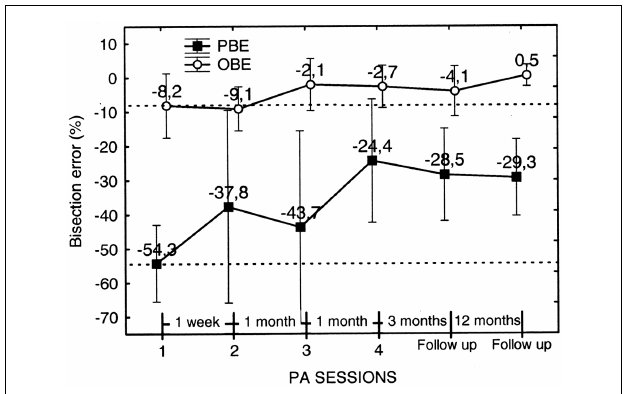
FIGURE 12 | Graphic representation of the effect on the walking bisection error of individual PA sessions (1–4) and of the duration of the effect (follow-up) . Each point represents the pre-adaptation bisection error, i.e., the error measured prior to each PA.The pre-adaptation error measured in session 1 serves as baseline (upper and lower dashed lines). Note that the effect of PA in terms of error reduction a) is greater for the predicted (PBE) than for the observed (OBE) bisection error and b) it is maintained at follow-up 3 and 15months after the last PA session (no. 4). Error bars represent standard errors. Bisection error is expressed as % deviation with respect to half line length. Negative and positive values indicate errors to the left and to the right of the target objective midline, respectively. See text for